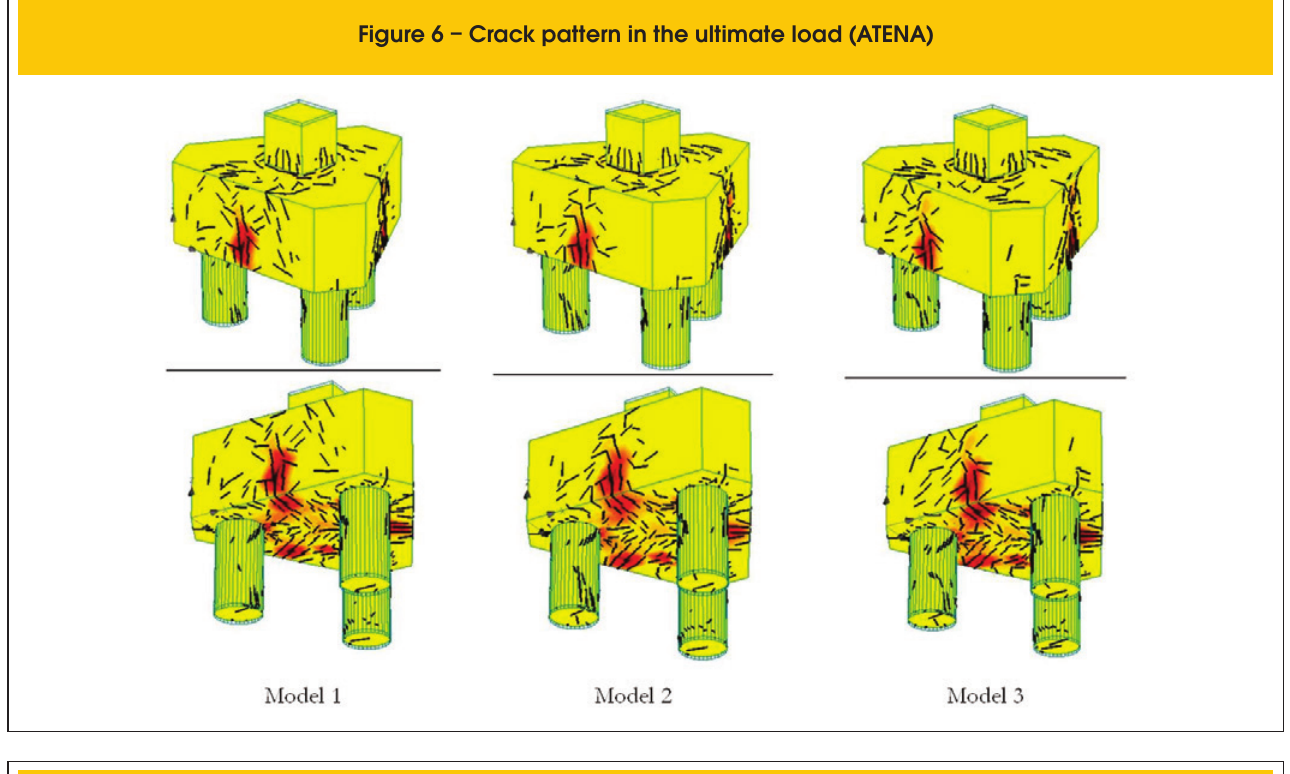
Table 6 – Ultimate load variation (  f ) in relation to the concrete compressive strength